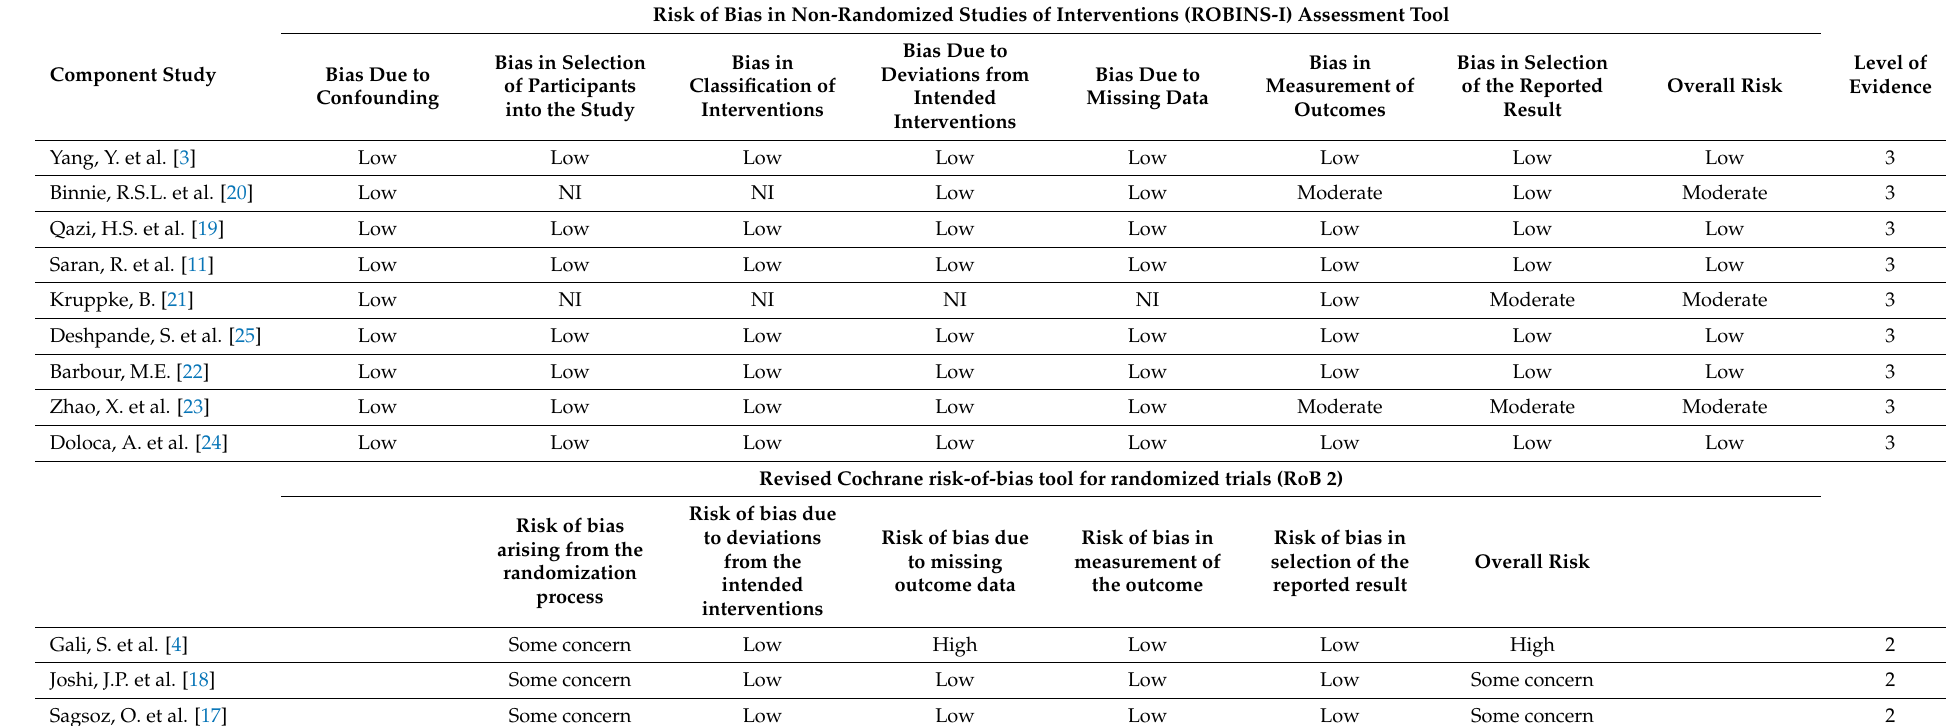
Table 3. Risk of bias and level of evidence of the selected primary studies based on the ROBINS-I, RoB 2 and OCEBM tools,